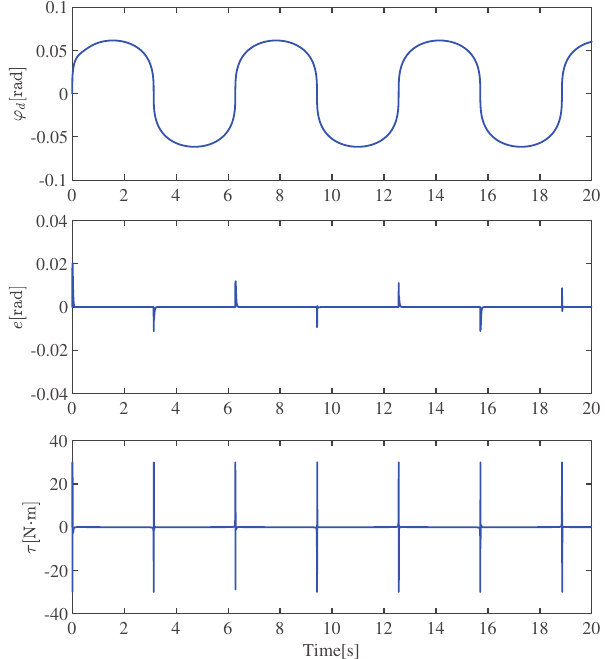
Figure 9. The simulation results with load mass